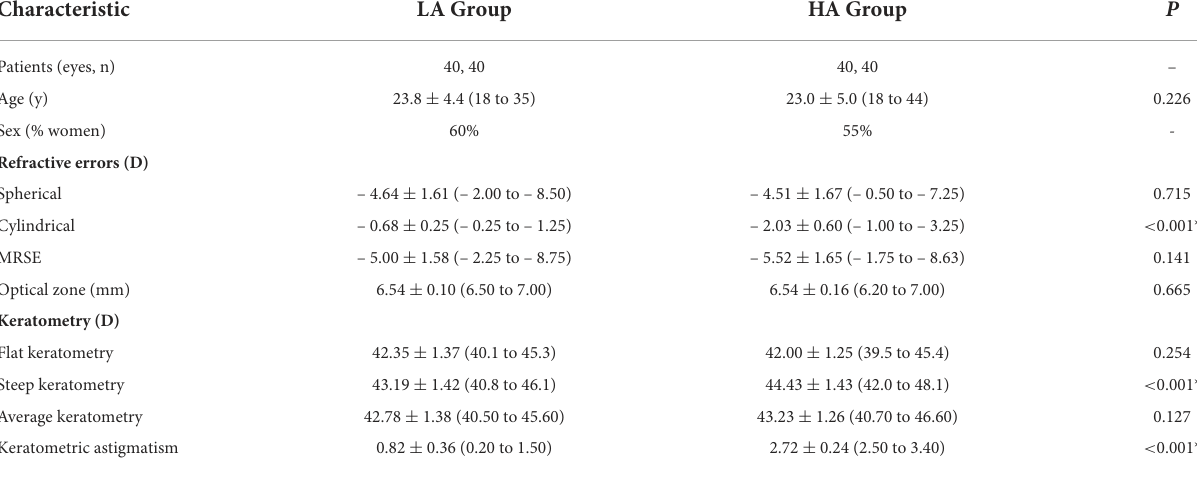
TABLE 1 Clinical characteristics of eyes that underwent